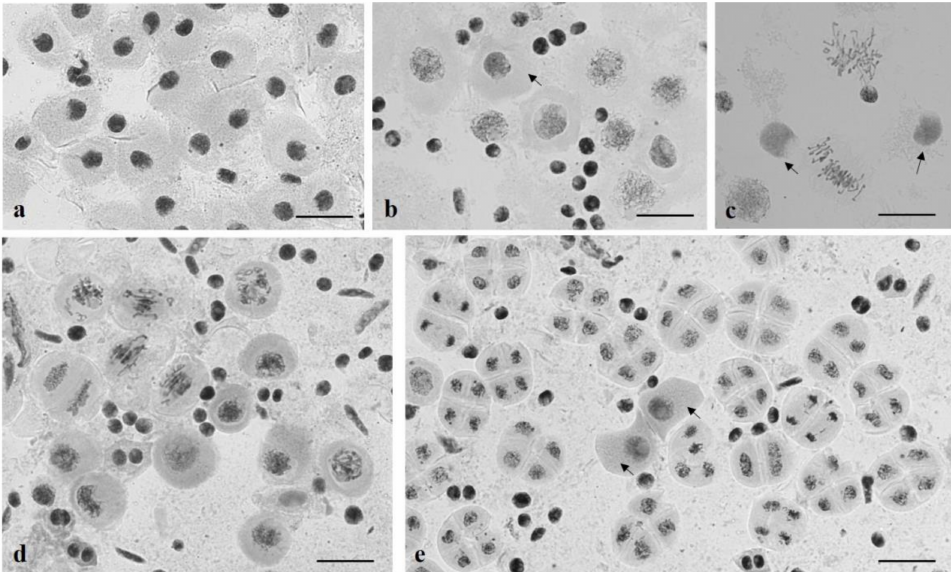
Figure 19. Meiocytes at early prophase stages retard in development in plants of Group 3. ( a ) The leptotene–zygotene stage; all meiocytes develop synchronously; ( b ) a meiocyte at the zygotene stage amid meiocytes at the pachytene stage; ( c,d ) meiocytes at prophase amid meiocytes at MI, TI; (e ) a meiocyte at the zygotene stage amid meiocytes at the tetrad stage. Staining acetocarmine. Scale bar = 10 µ